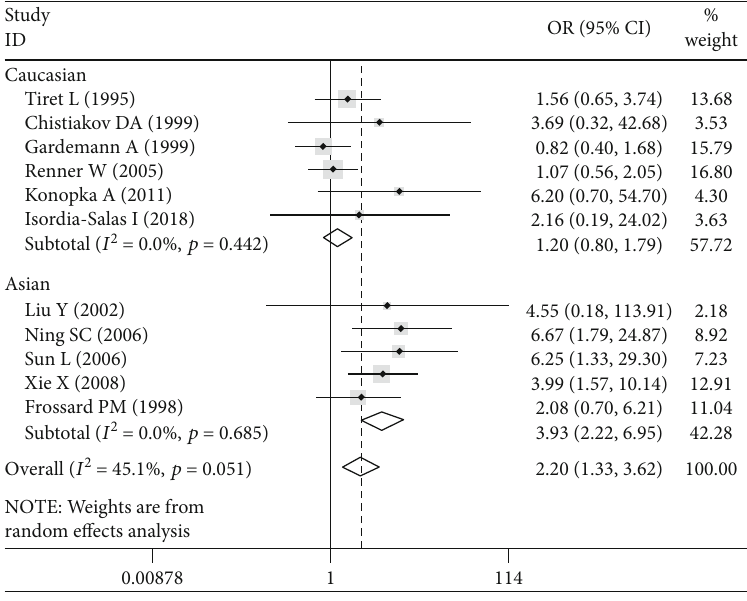
= 0 : 685 ), and additive heterogeneity